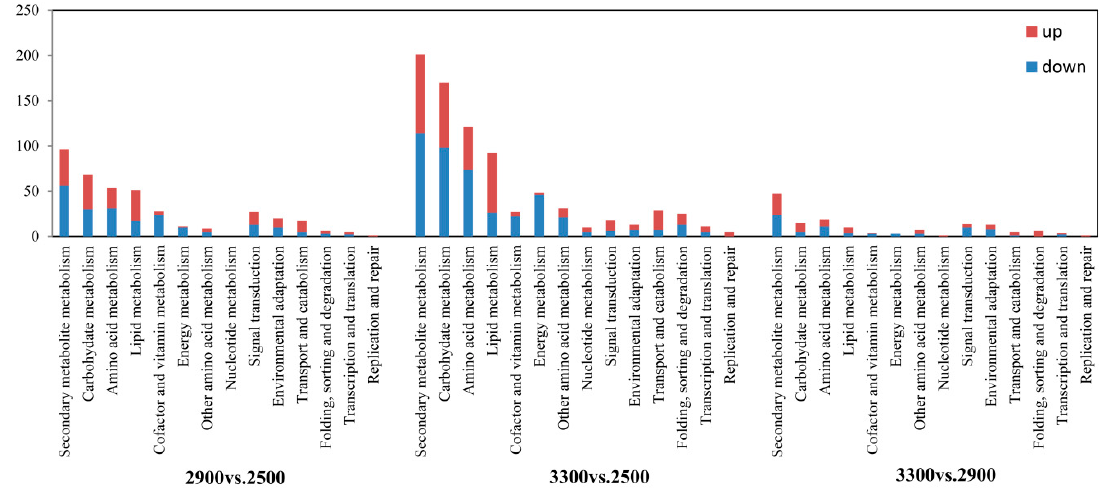
Figure7. KyotoEncyclopediaofGenesandGenomes(KEGG)pathwaysin Piceacrassifolia Figure 7. Kyoto Encyclopedia of Genes and Genomes (KEGG) pathways in Picea crassifolia with elevations.